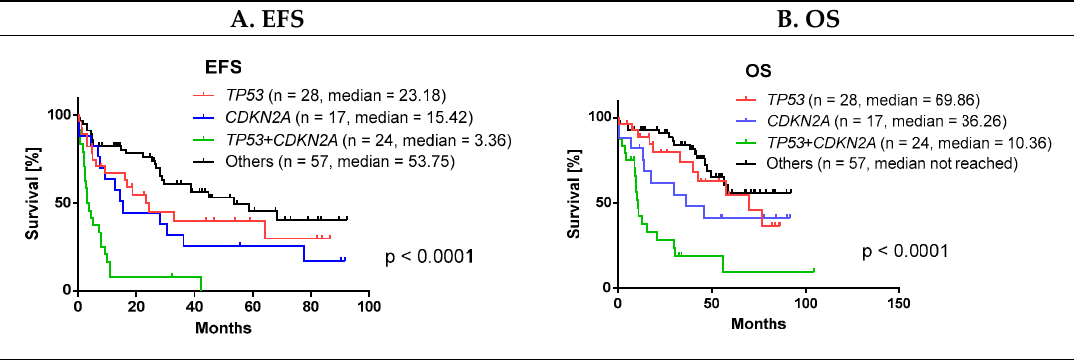
Figure 5. Patients with concurrent TP53 and CDKN2A aberrations have significantly shorter survival than isolated aberrations. Patients in groups TP53 and CDKN2A are patients with TP53 aberrations or CDKN2A deletions that are not contained in the TP53 + CDKN2A subcohort. ( A ) EFS, ( B ) OS. EFS = event-free survival, OS = overall survival.